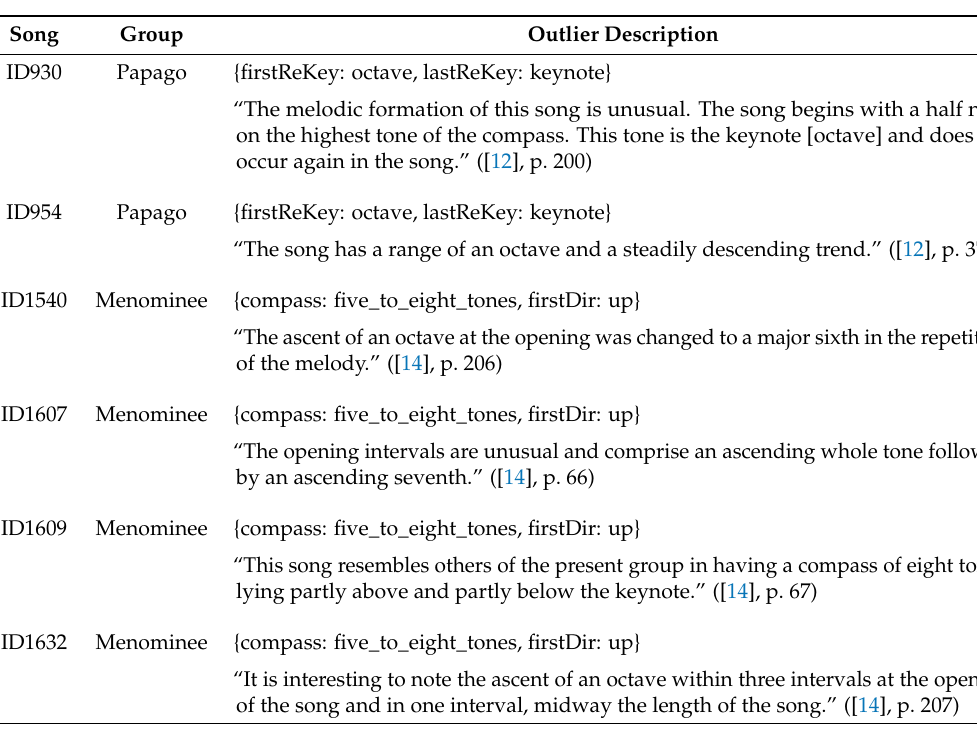
Table 5. Outliers in the Densmore collection with significantly infrequent feature